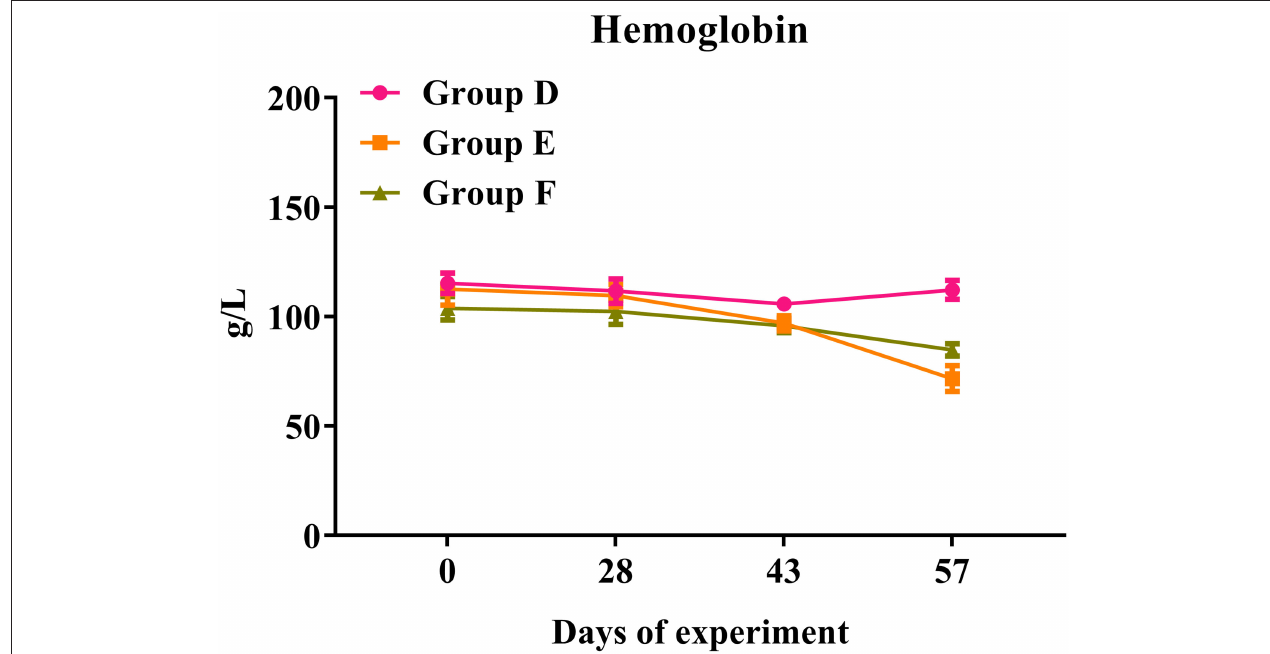
FIGURE 8 | Hemoglobin levels in trial 2. Group D, unchallenged goats; Group E, goats challenged with L3s; Group F, goats vaccinated by rHc8 antigen mixed with Freund’s adjuvants (at day 0 and 15), and challenged with L3s (at day 29). Hemoglobin (HGB) contents of blood samples were determined. Data are shown as means ±